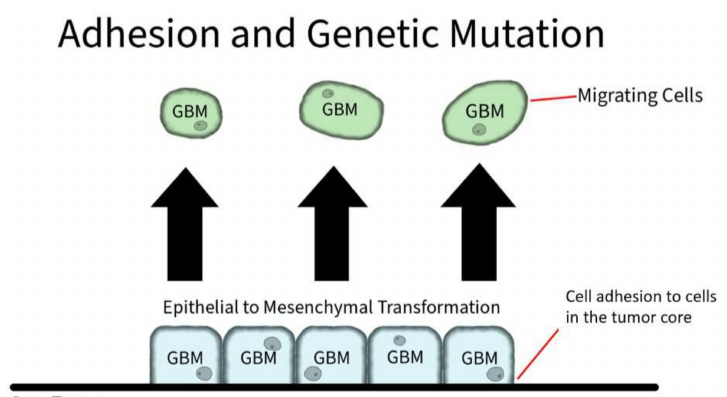
Figure 8. Adhesion and Genetic Mutation in GBM. Cellular membrane proteins play a role in individual GBM cell adhesion to the core tumor. However, through genetic mutation, GBM cells can induce an overexpression of hyaluronic acid, which serves as a ligand for CD-44 receptors. The CD-44 receptors activate SRC complexes that induces a shift to mesenchymal shift in